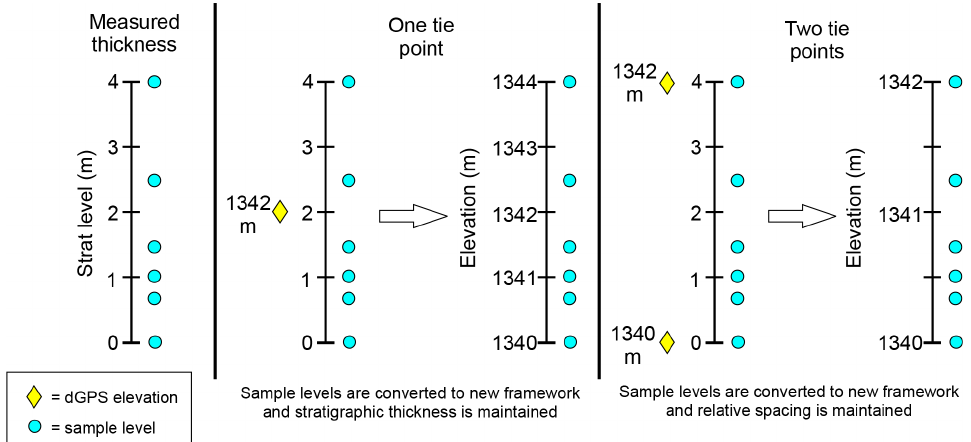
Figure A8. Conversion between measured stratigraphic thickness and elevation using one or two tie points. The same method was used for converting to BCM levels using correlated fossil localities as tie